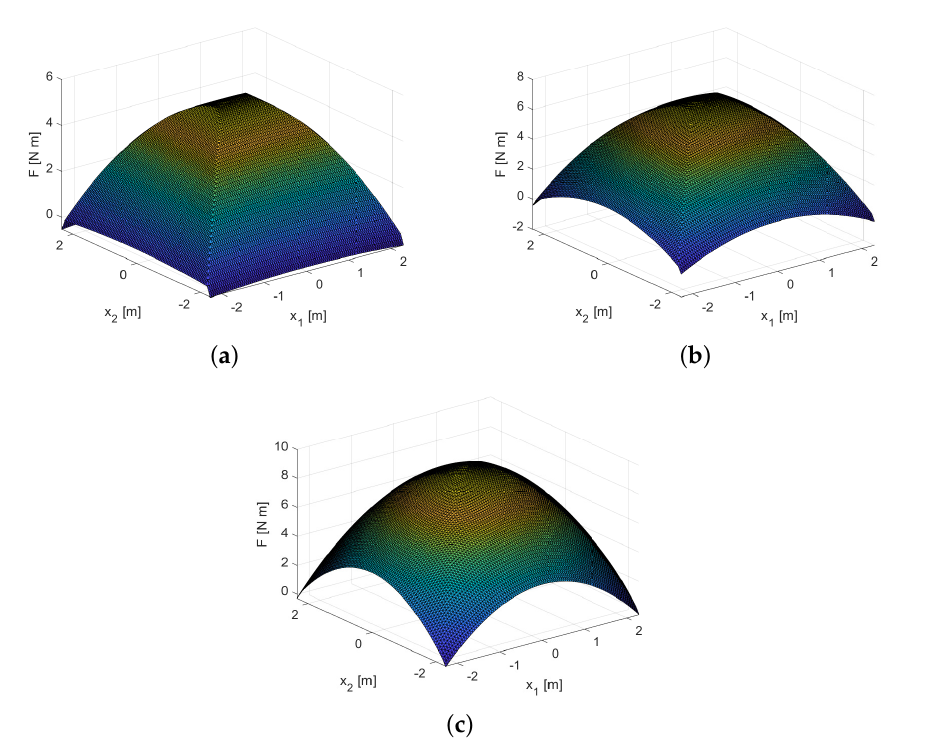
Figure 15. Stress potential for ( a ) β = 0, ( b ) β = 0.3, and ( c ) β =